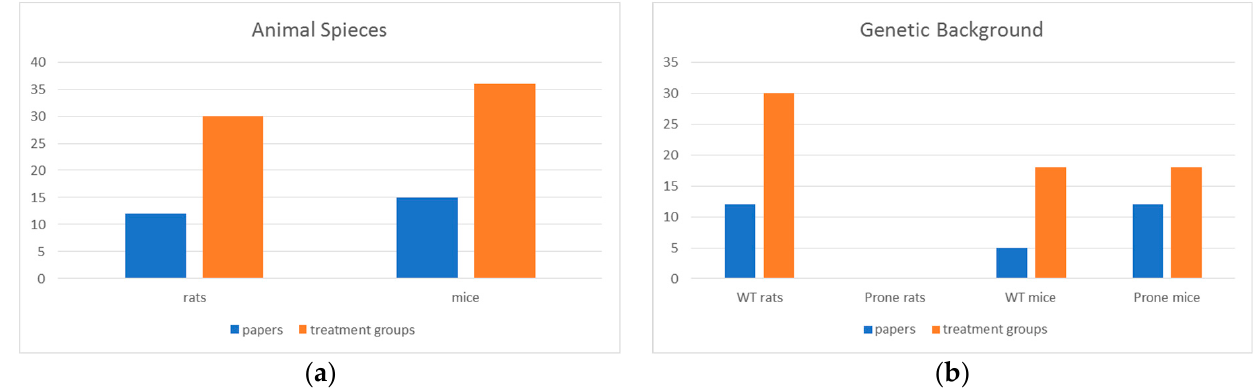
Figure 2. Distribution of papers and treatment groups for the ( a ) animal species and ( b ) genetic background.